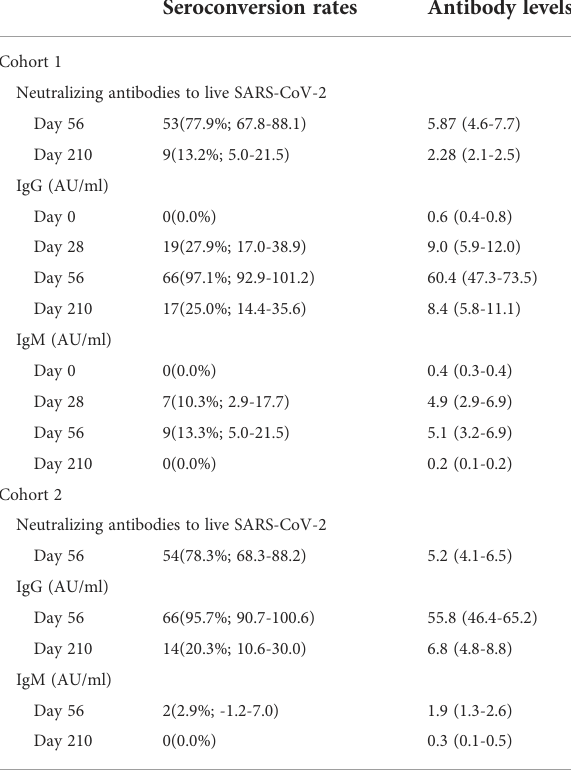
TABLE 2 Seroconversion rates of antibodies to live SARS-CoV-2, IgG and IgM. Seroconversion rates Antibody